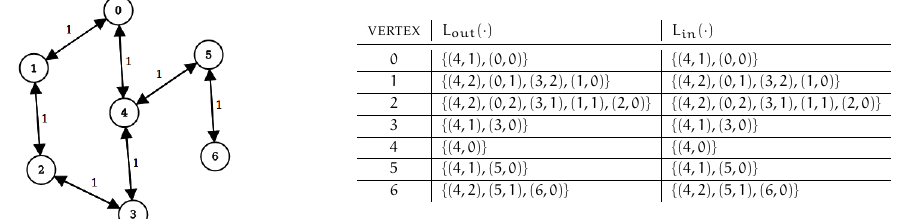
Figure 1. A sample graph and a corresponding 2- HOP - COVER labeling is shown. Vertex ordering is { 4 , 0 , 3 , 1 , 2 , 5 , 6 }